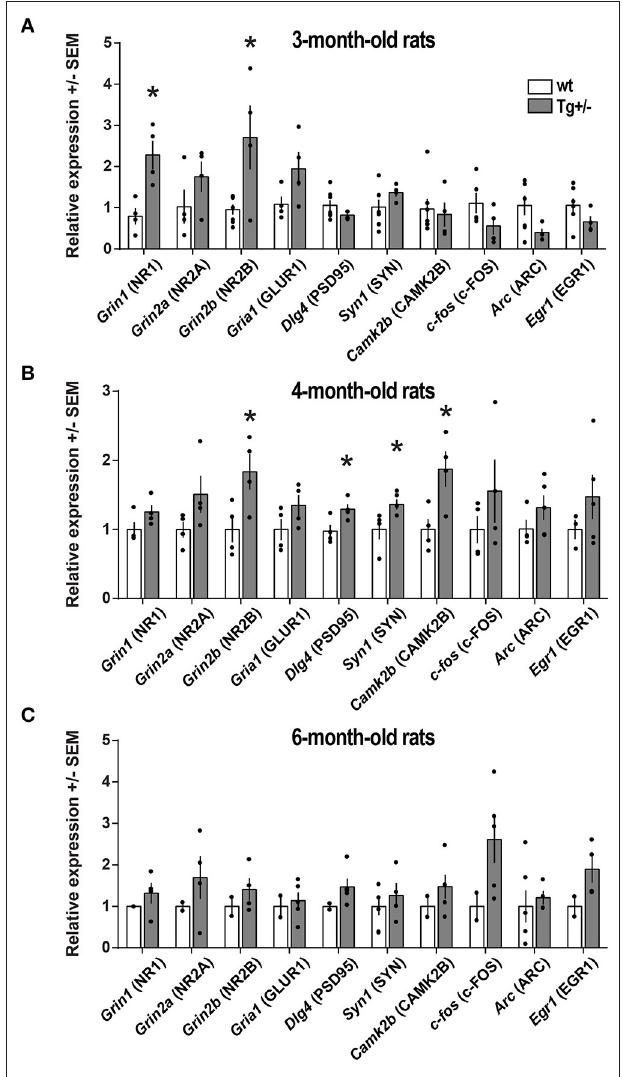
FIGURE 6 | Expression of synaptic plasticity-associated genes. Total RNA was extracted from the hippocampus of (A) 3-month-old (N wt = 7; N Tg + / − = 4), (B) 4-month-old (N wt = 4; N Tg + / − = 4) and (C) 6-month-old (N wt = 6; N Tg + / − = 5) McGill-R-Thy1-APP Tg + /– male rats and their wt littermates. The relative expression of each transcript was calculated using the 11 CT method and standardized against the housekeeping genes 18S, GAPDH, HPRT, and β -actin. The name of the corresponding protein product is also indicated. Statistically significant differences were assessed by a two-tailed, unpaired t -test; * P <